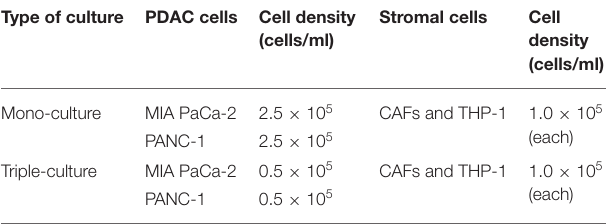
TABLE 3 | Cell seeding density used for 3D cell cultures. Type of culture PDAC cells Cell density